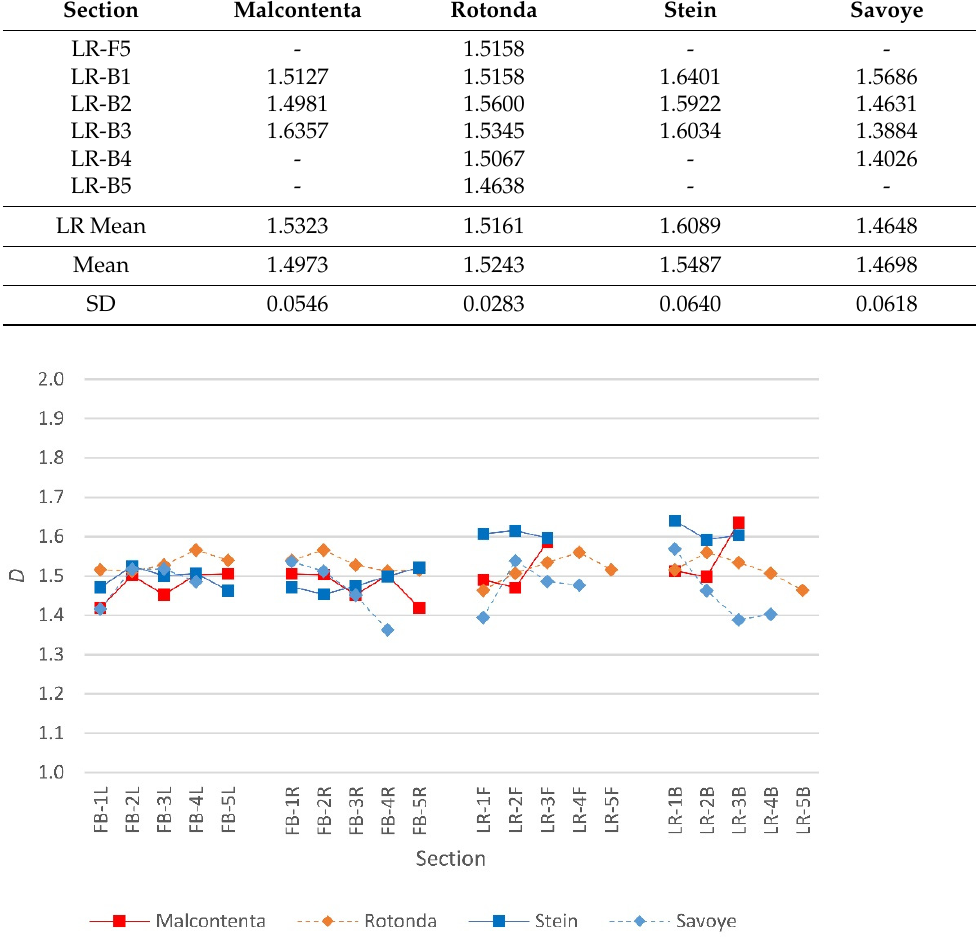
Figure 9. D values of sections. Table 3. D values of sections.